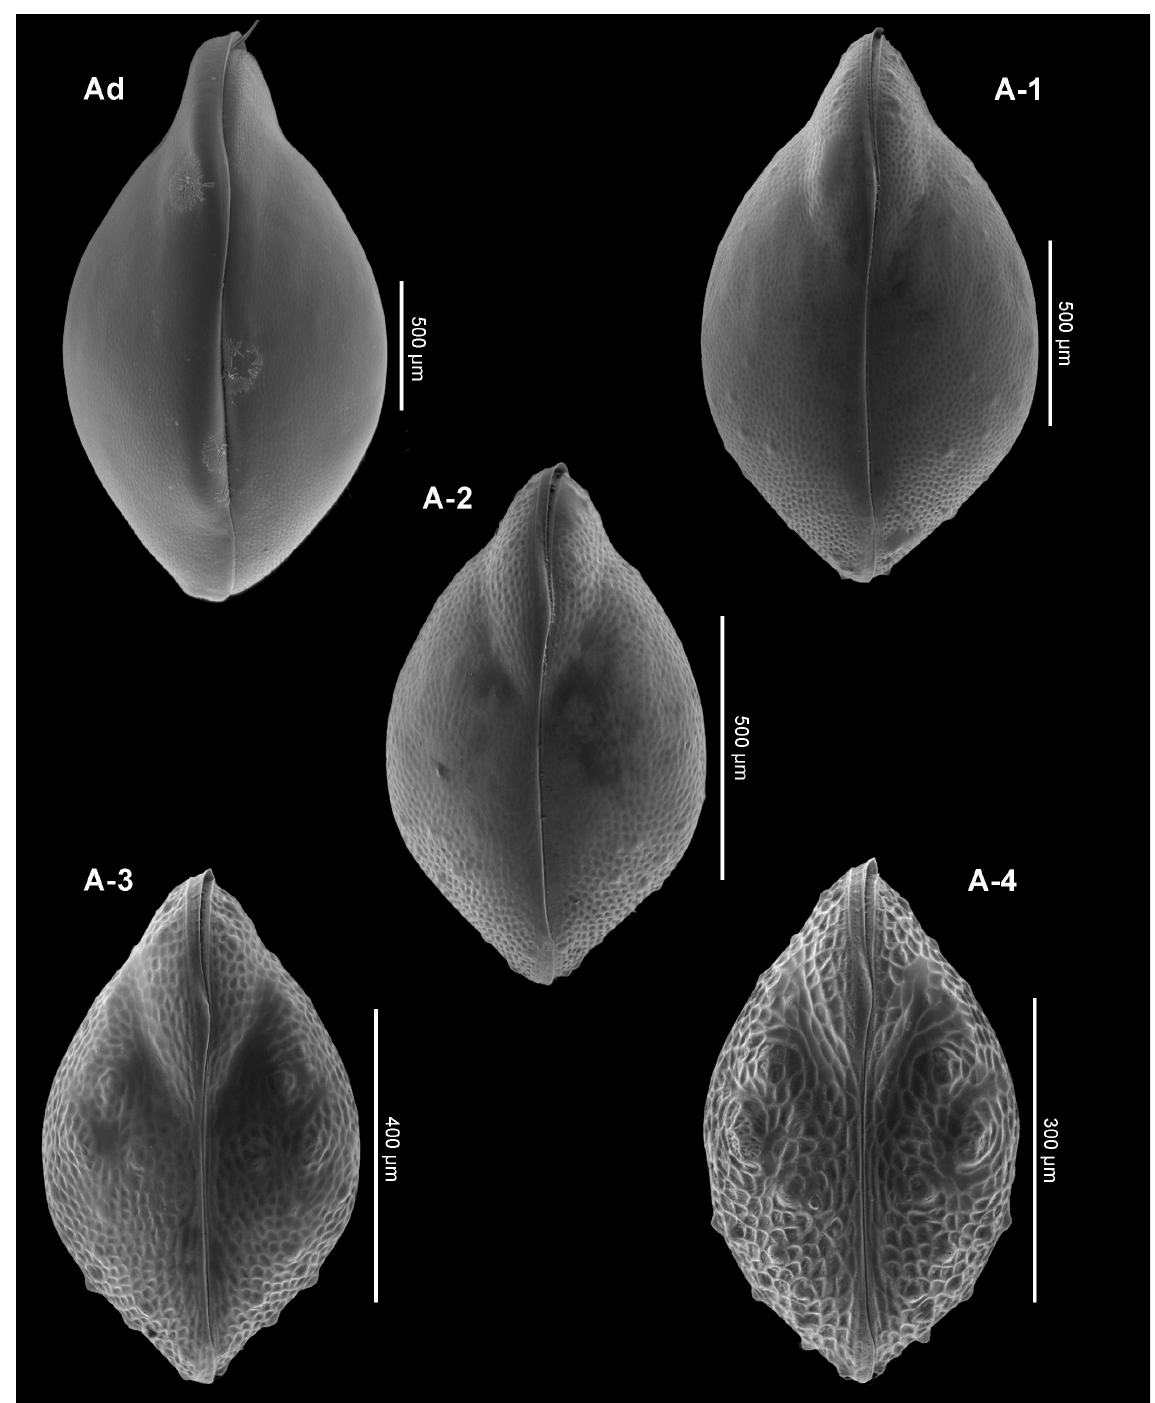
Fig. 13. Bennelongia kimberleyensis Martens et al ., 2012 from Taylor’s Lagoon. Dorsal views of carapaces of different moult stages going from adult to A-4. Note the highly ornamented A-4 carapace with at least 2 sets of domes (and prominent cones) that are still visible in A-3, and not visible in the other stages. Only a few cones are seen in the A-1 specimen, and no ornamentation is visible in the adult